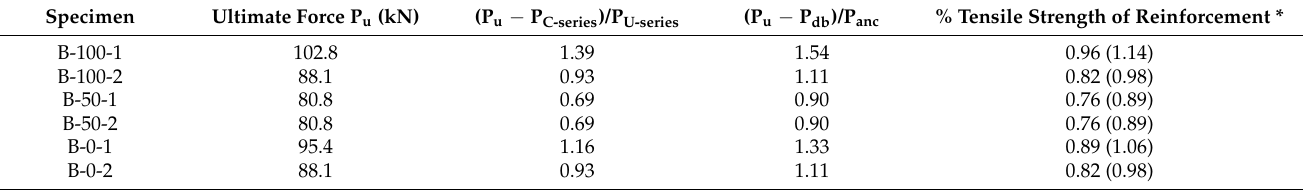
Table 3. Exploitation of sheets and connectors in bonded, anchored beams.